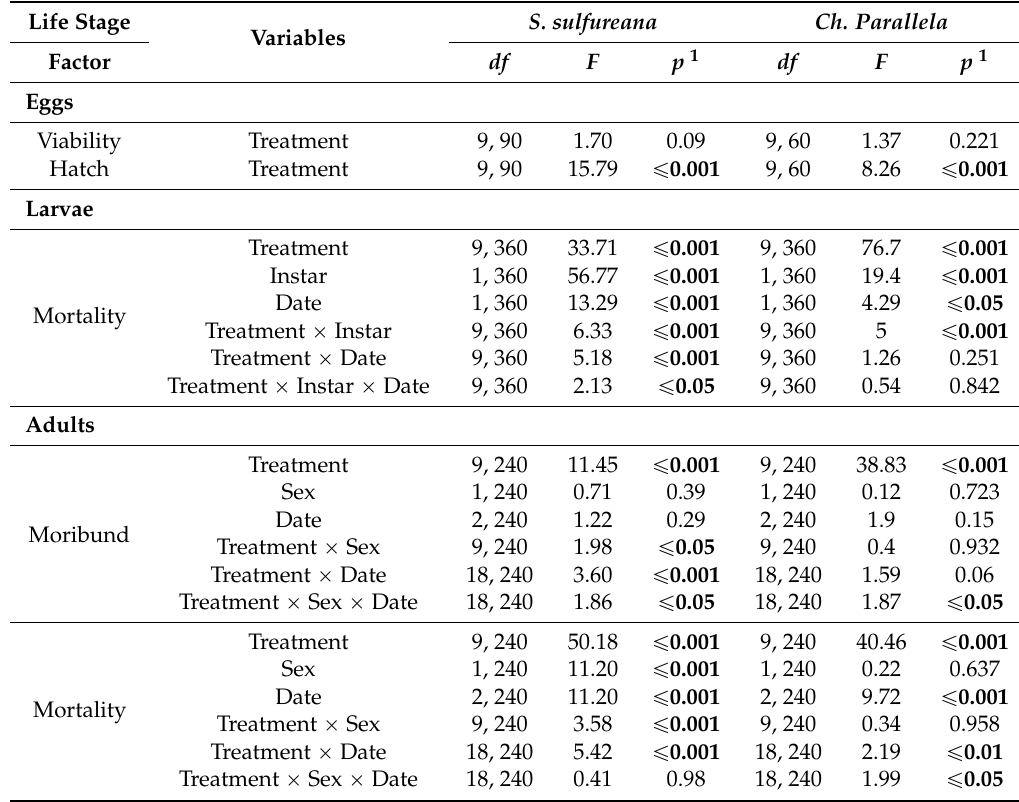
Table 2. Results from analysis of variance (ANOVA) for laboratory studies on the effects of insecticides, days after treatment, instar (1st versus 3rd), and gender on Sparganothis sulfureana and Choristoneura parallela percent egg viability and hatch, larval mortality, and adult knockdown (moribund) and